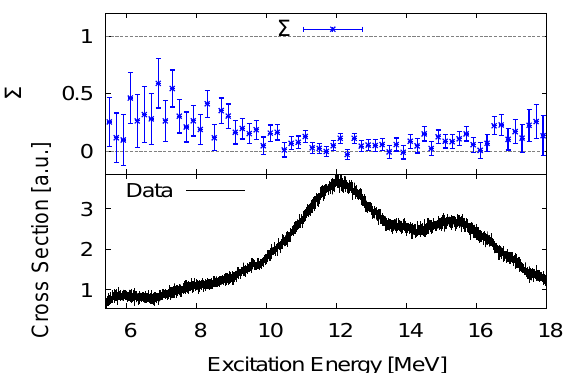
Fig. 5. (color online) Total spin transfer Σ (upper panel) and the corresponding energy bins (width of 200 keV) in the excitation energy spectrum (lower panel) for the reaction 154 Sm( p , p (cid:48) ) at a proton energy of 295 MeV at 0 ◦